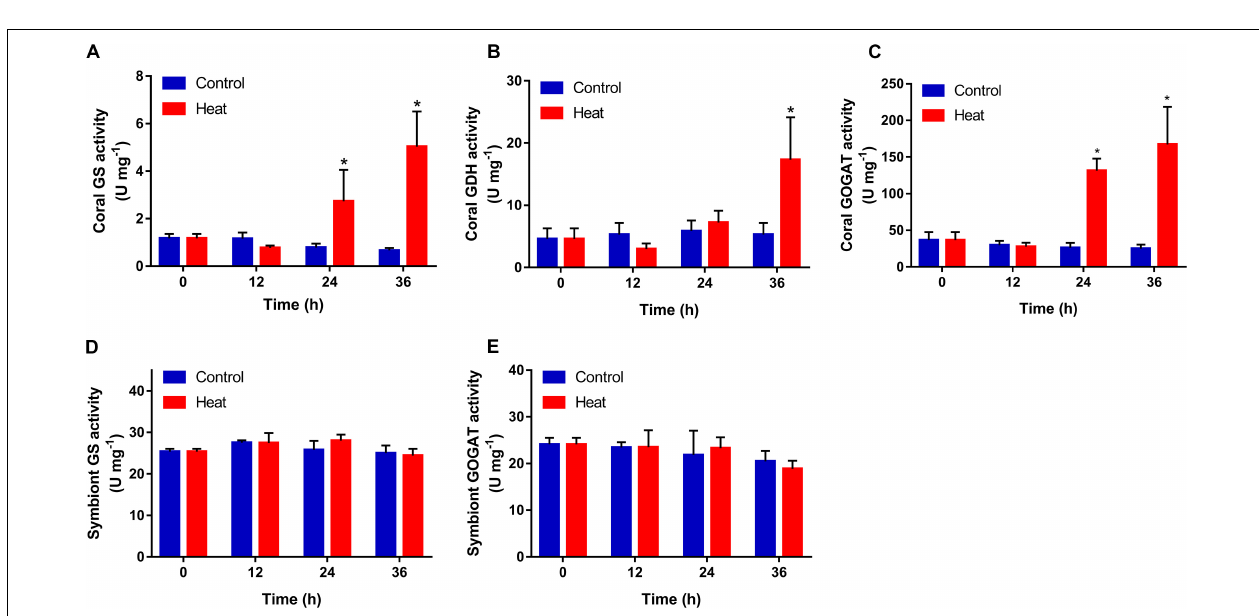
FIGURE 2 | Temporal patterns of redox-related enzyme activities in the scleractinian coral Pocillopora damicornis and its symbionts after heat treatment. (A) Nitric oxide synthetase (NOS) in the coral. (B) Superoxide dismutase (SOD) in the coral. (C) Catalase (CAT) in the coral. (D) NOS in the symbionts. (E) SOD in the symbionts. (F) CAT in the symbionts. Data points represent means and error bars represent standard deviations ( N = 6). Asterisks depict significant differences between the heat and control groups ( p < 0.05).